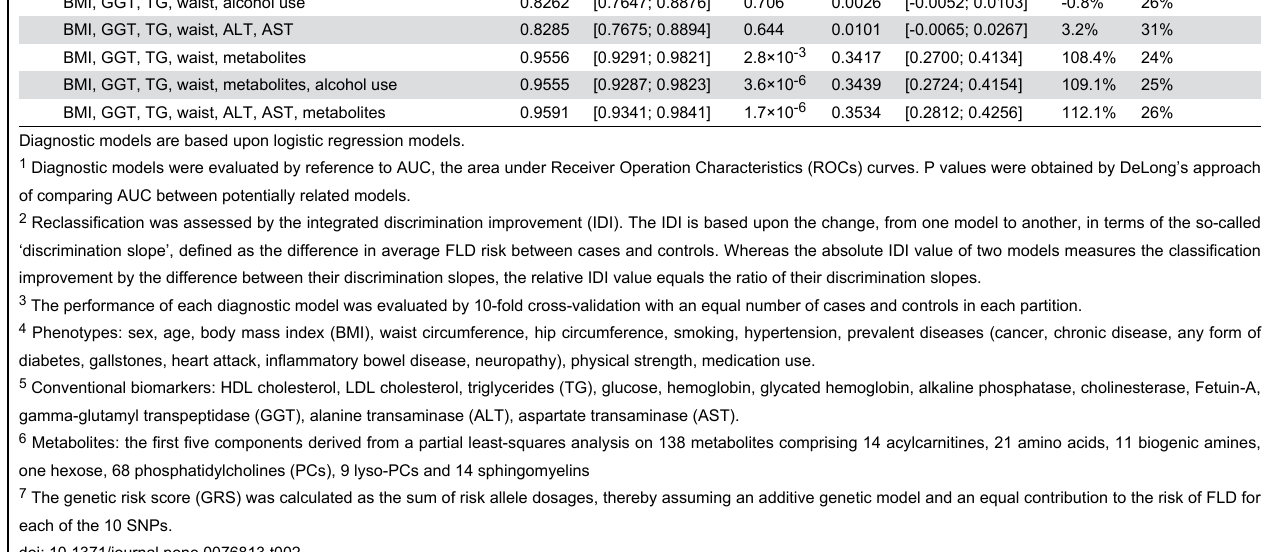
The genetic risk score (GRS) was calculated as the sum of risk allele dosages, thereby assuming an additive genetic model and an equal contribution to the risk of FLD for each of the 10